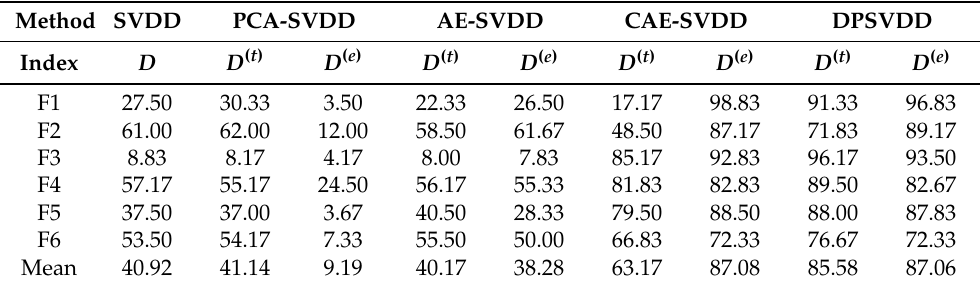
Table 3. Fault detection rates (FDRs)(%) of the six tested faults by the five compared methods.